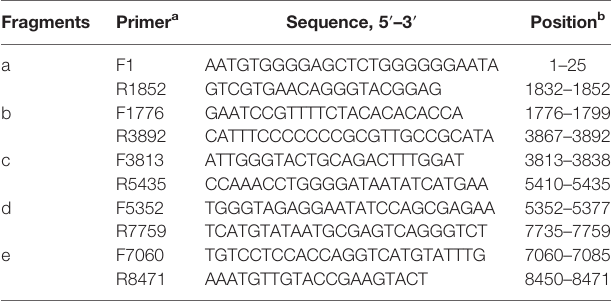
TABLE 1 | Primers used for PCR ampli fi cation of the reticuloendotheliosis virus whole genome.